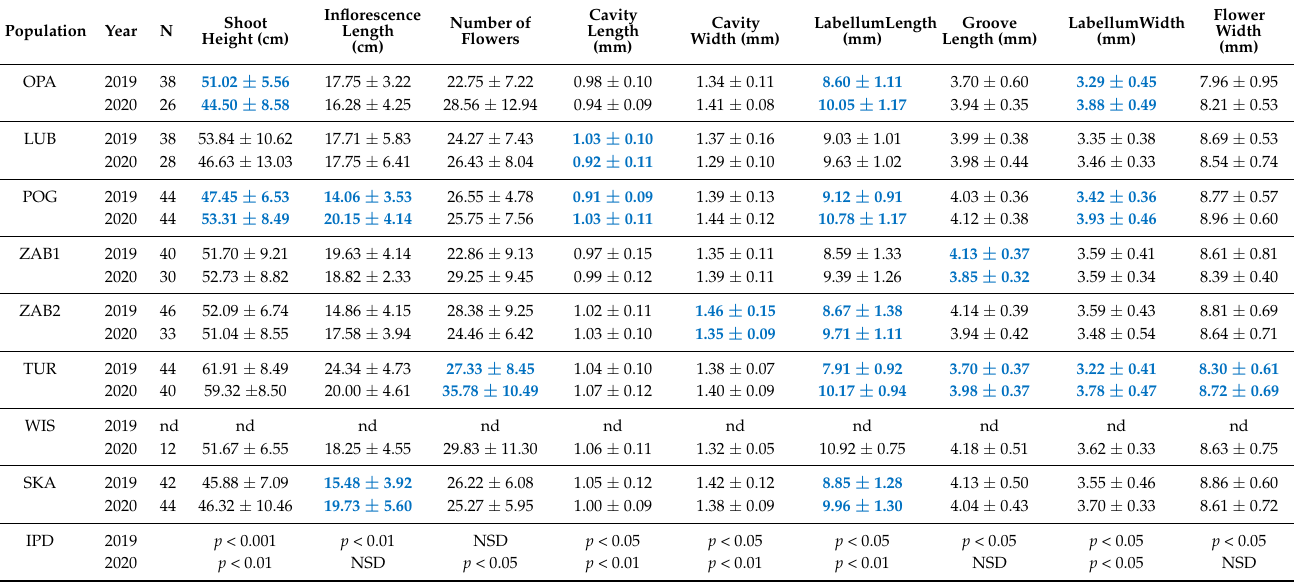
Table 1. Variation of floral display and flower structure in Neottia ovata populations. Data show the mean ± standard deviation. Dark blue values in bold indicate statistically significant differences between years.